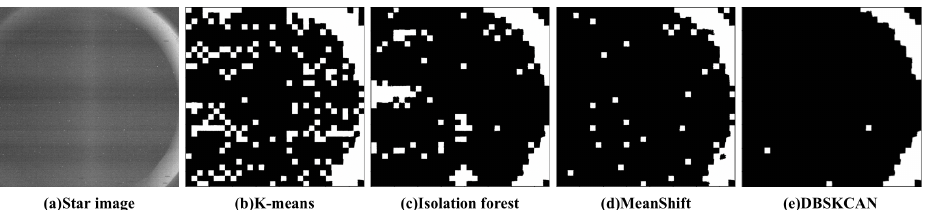
Figure 10. ( a ) The star image with strong interference and result of ( b ) K-means [46]; ( c ) Isolation forest [47]; ( d ) Meanshift [48]; and ( e ) DBSCAN [45]. In the binary image, white pixels are the region of large-area interference. The black pixels are the region of the